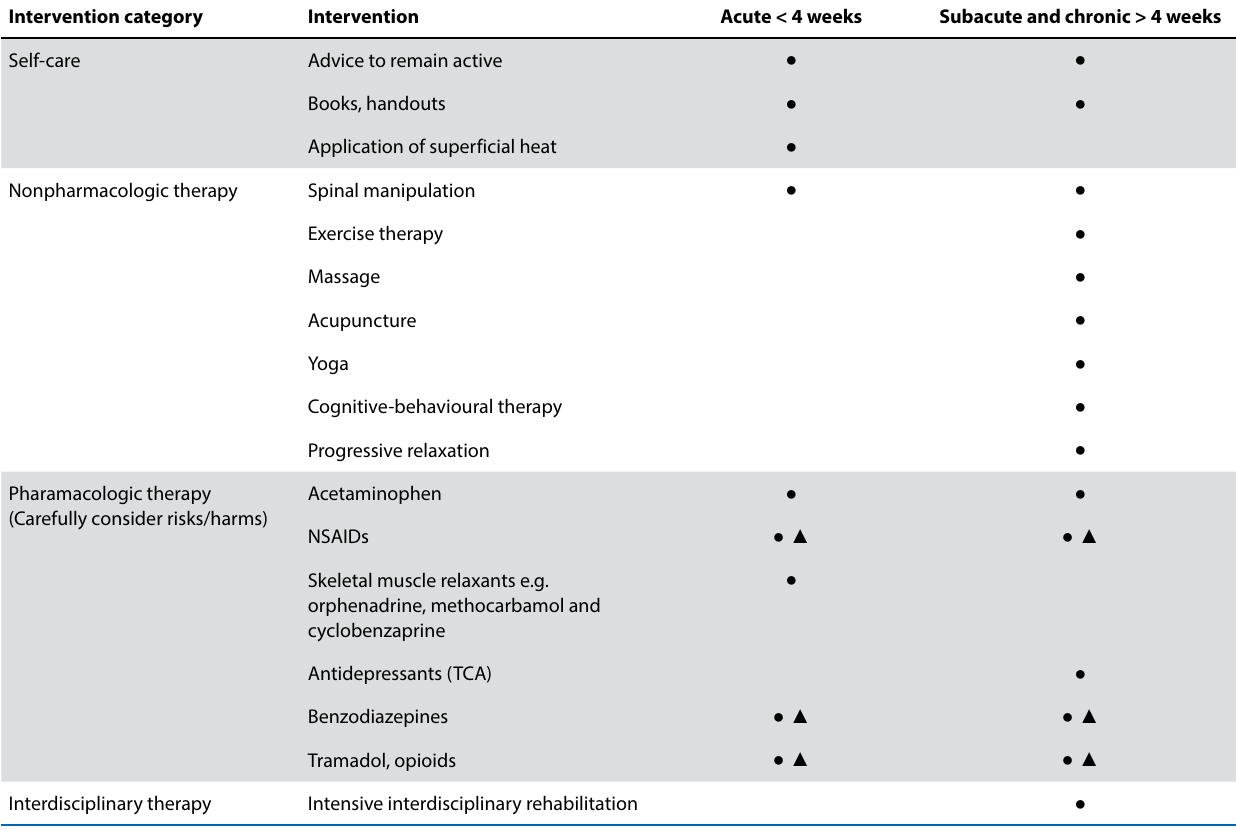
Table I: Interventions Intervention category